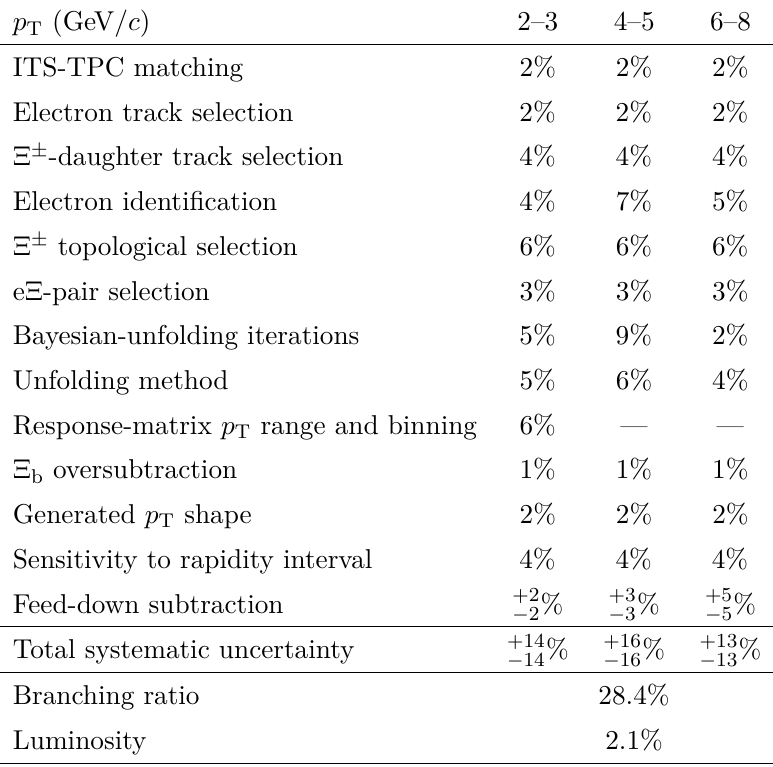
cross section for the p T intervals c